Question: What visual encoding does this figure use to show its data?
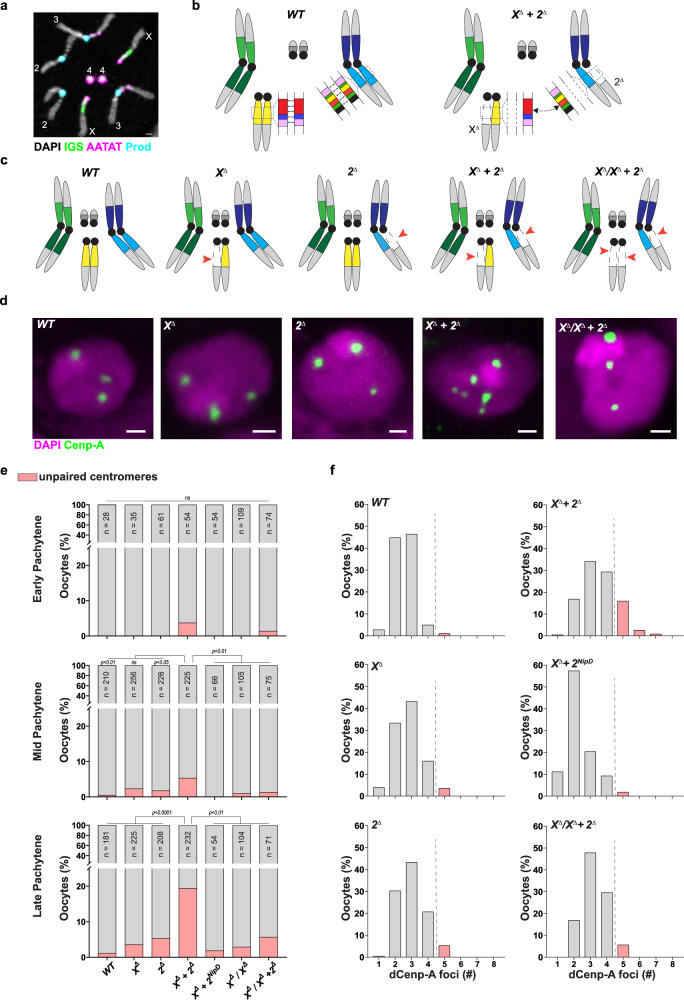
Answer: histogram